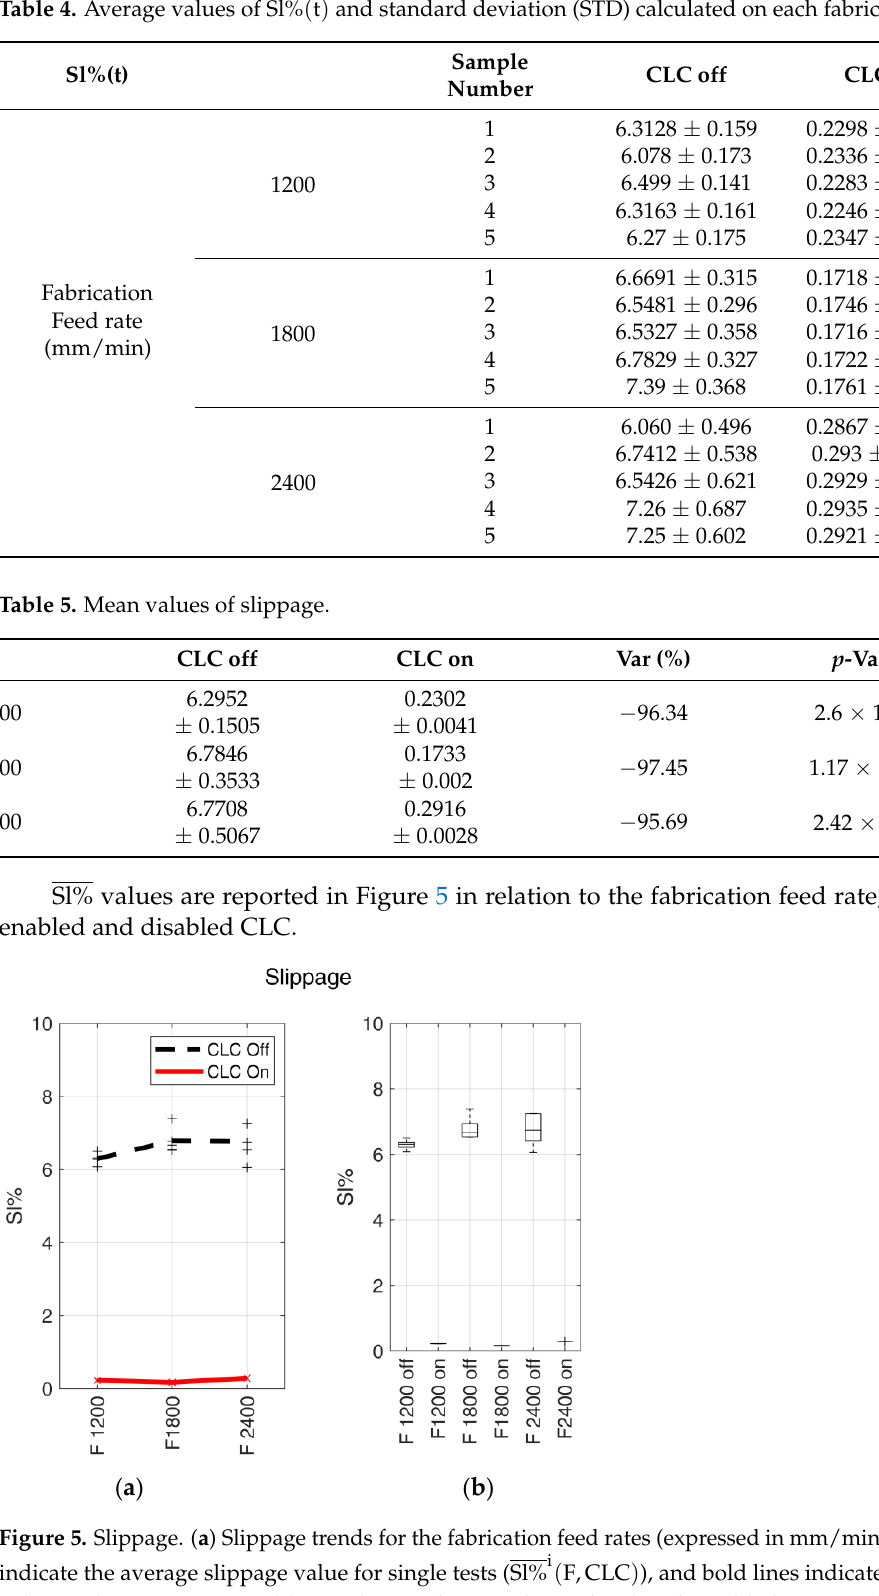
Table 4. Average values of Sl% ( t ) and standard deviation (STD) calculated on each fabrication job.